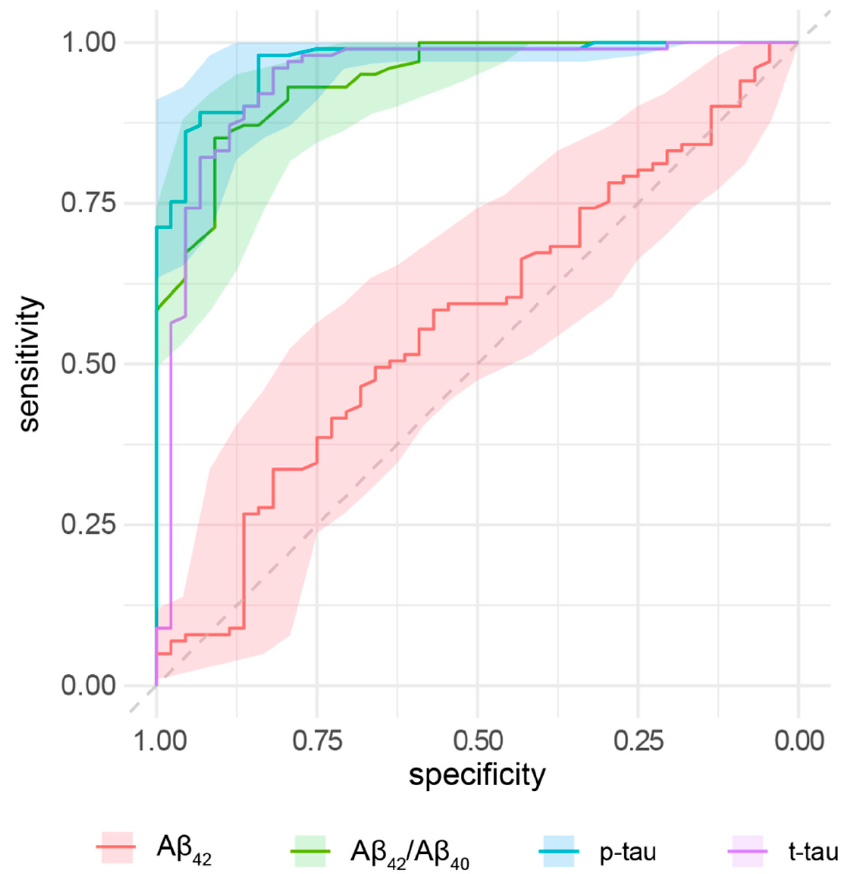
Figure 4. ROC curves for the accuracy of A β 42 , A β 42 /A β 40 , p-tau, and t-tau in distinguishing iNPH and AD. Colored shapes indicate 95% C.I.